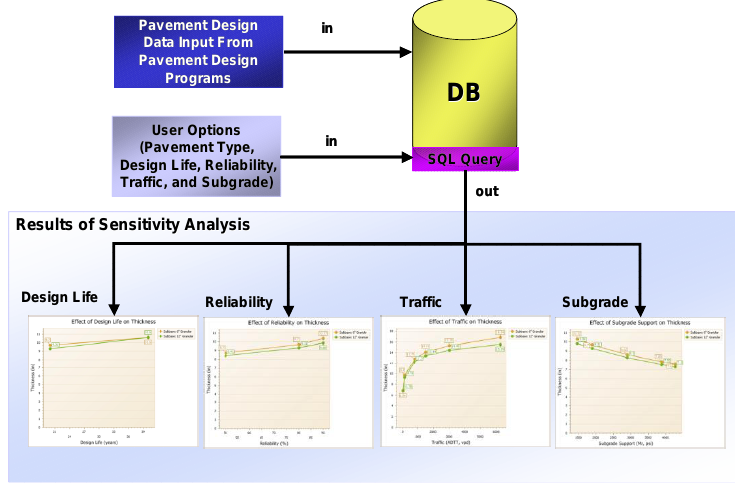
Figure 5. Flow chart of pavement design and sensitivity analysis (PDSA) software.